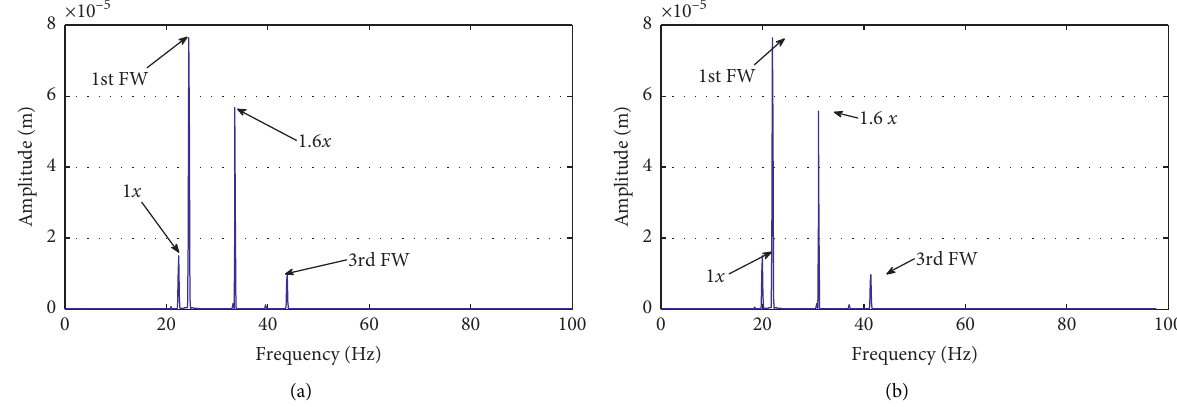
Figure 10: Spectrum of out-of-balance at bearing 4 (outer rotor): (a) horizontal direction and (b) vertical